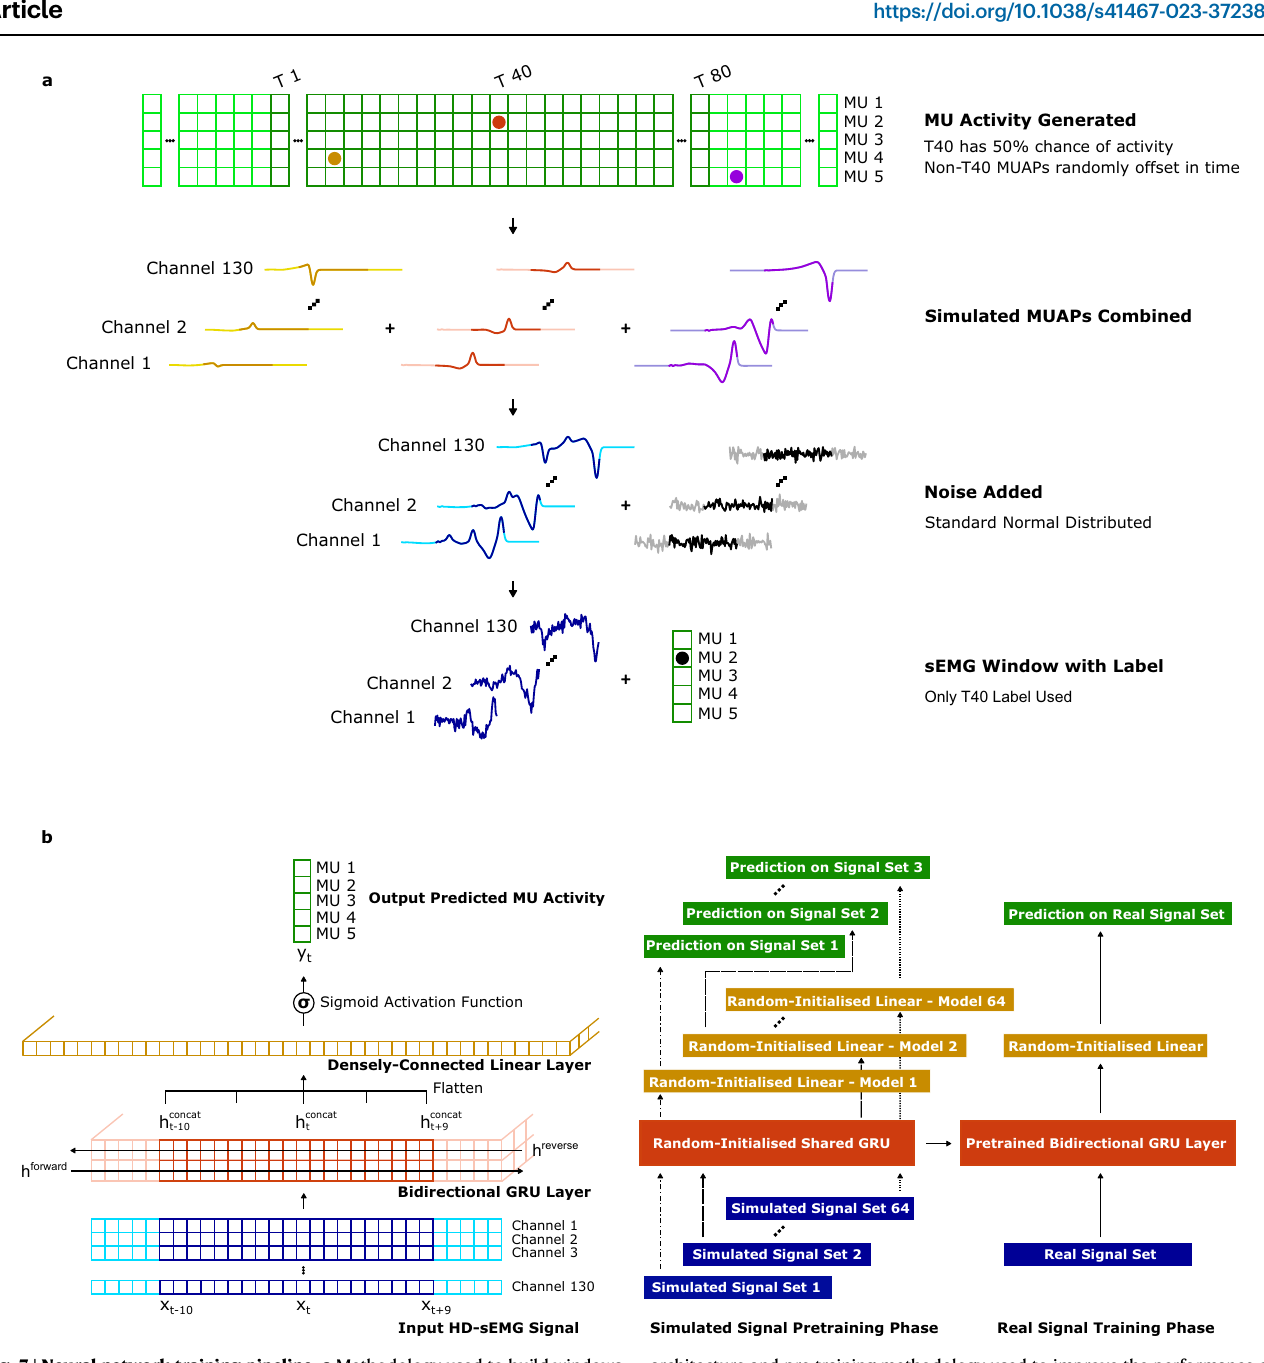
architecture and pre-training methodology used to improve the performance of a deep learning-based HD-sEMG decomposition algorithm. The neural network consists of a single gated recurrent unit layer, with predictions made using a 20- sample wide window of the hidden vector output, which is fl attened before being passed to a sigmoid-activated densely-connected linear layer. In the pre-training